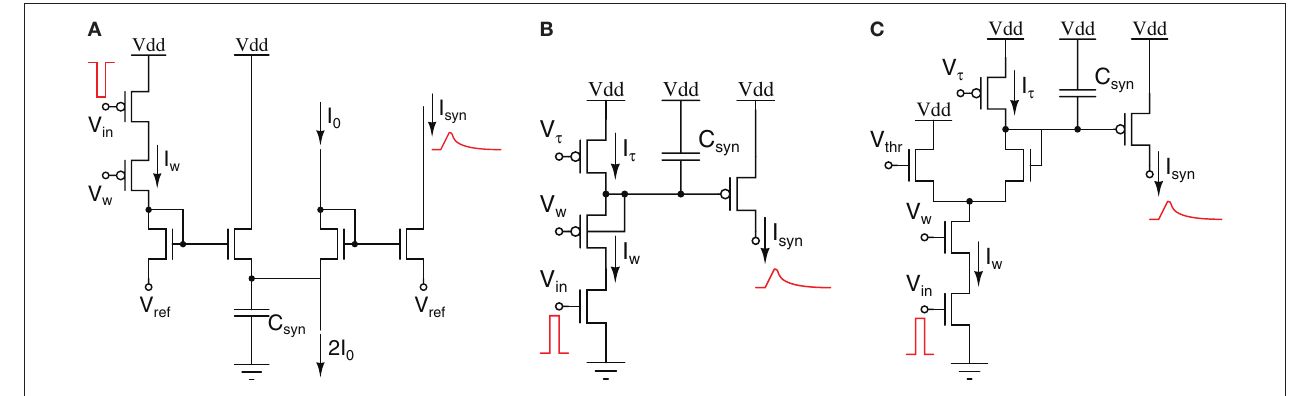
FIgure 1 | (a) “Tau-cell” circuit: log-domain circuit used to implement a first-order low-pass filter (LPF); (b) Sub-threshold first-order LPF circuit; (C) “DPI” circuit: non-linear current-mode LPF